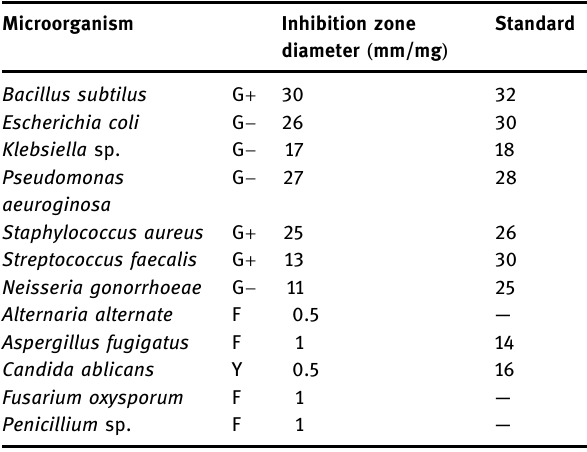
Table 2: Antimicrobial activity of Ag -